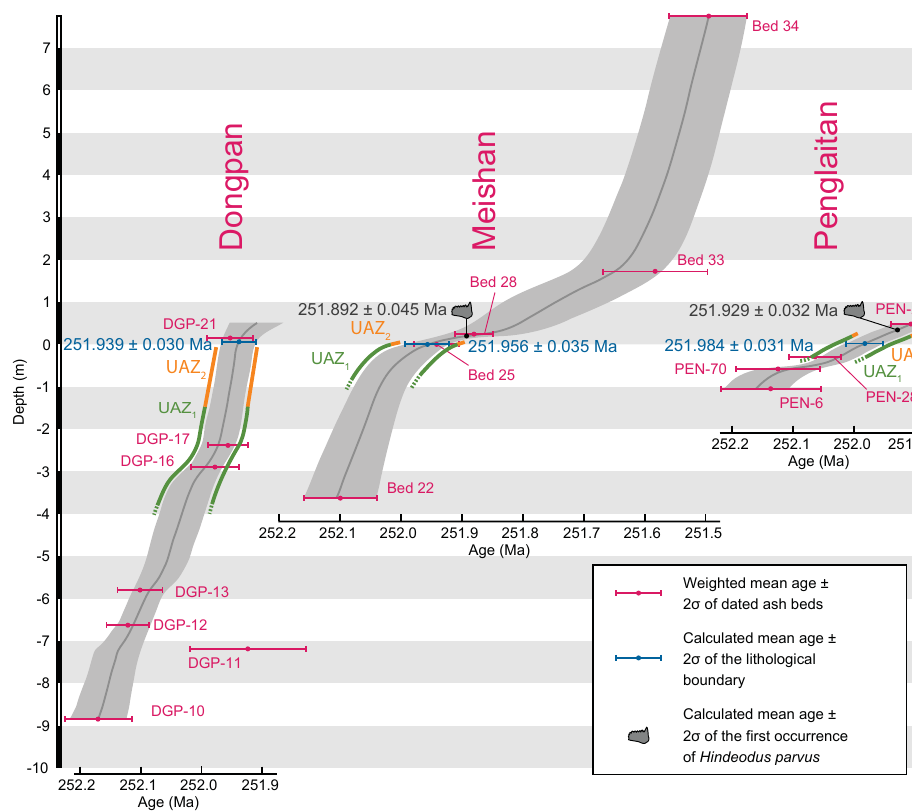
Figure 6. Comparison of Bayesian Bchron age models for Dongpan, Penglaitan and the Meishan GSSP. Predicted dates together with their uncertainty for the lithological boundaries and the first occurrence of the conodont Hindeodus parvus at Dongpan and Penglaitan are calculated using U-Pb ages of this study and of Baresel et al. (2016), and the U-Pb ages of Burgess et al. (2014) for Meishan. The durations of the conodont unitary association zones (UAZs) UAZ1 and UAZ2 (Brosse et al., 2016) are inferred from the Bchron age model of Meishan and projected to the model of Dongpan and Penglaitan,